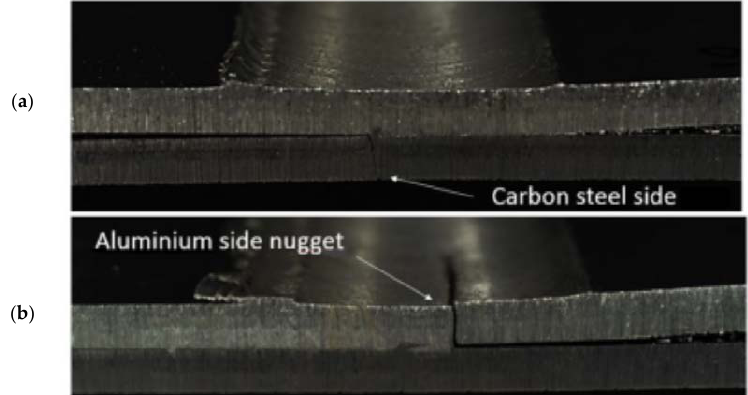
Table 5. Fatigue test process parameters and results on sample 3.